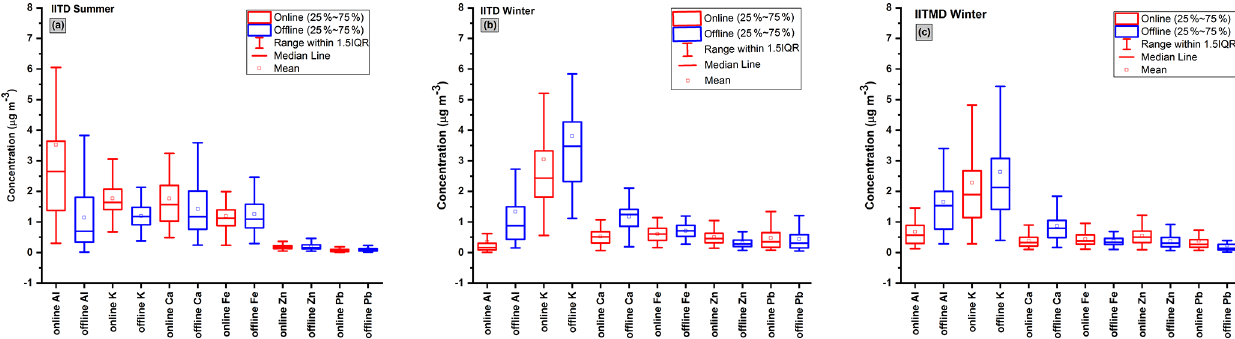
Figure 4. Box plots of some major elements measured offline and online during the (a) summer campaign at IITD, (b) winter campaign at IITD, and (c) winter campaign at IITMD. The box plots for the rest of the heavy and trace elements are shown in Fig. S4.